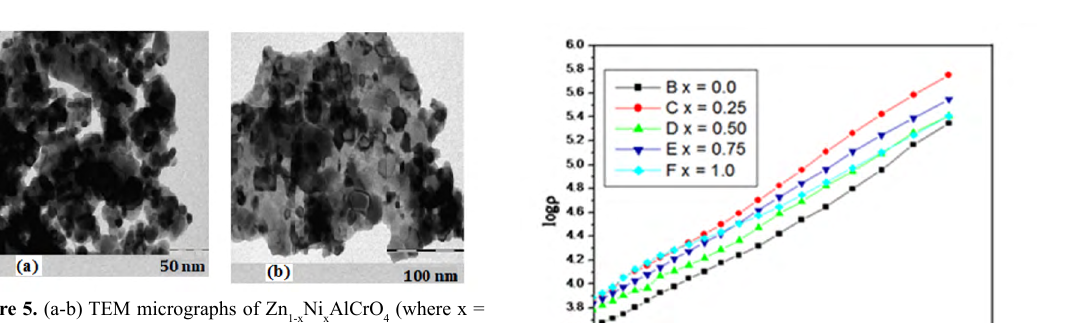
Ni AlCrO (x = 0.0; 0.50; 1.0) 1-x x 4